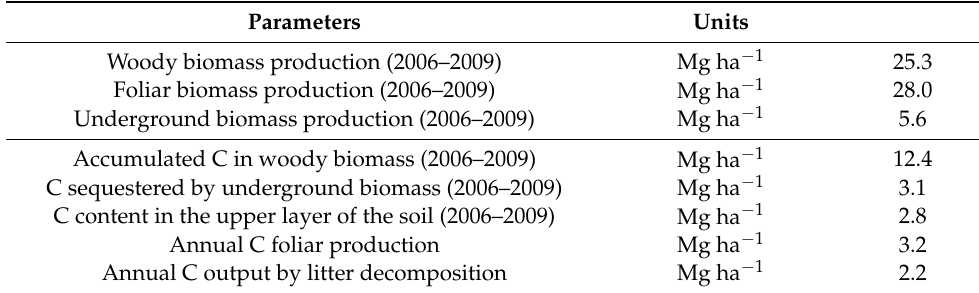
Table 5. C dynamics after a 3 year rotation